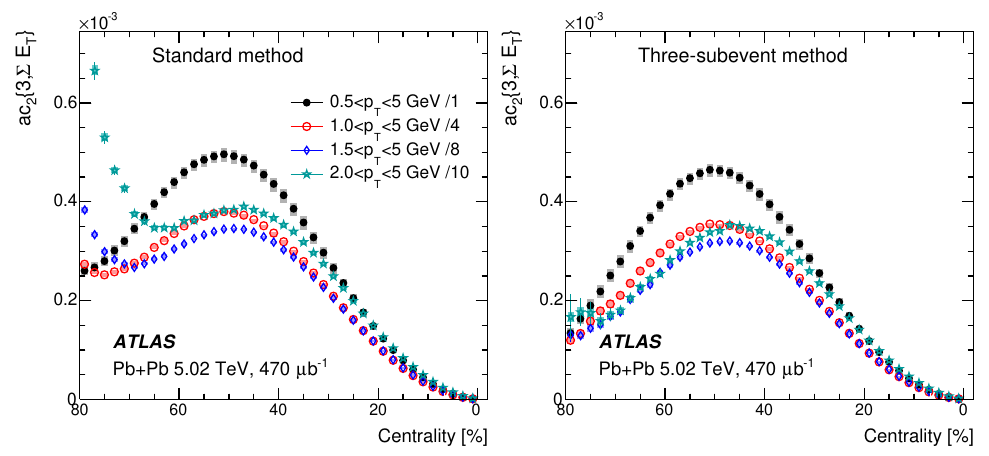
Figure 31 . The ac 2 f 3 g values calculated for charged particles in four p T ranges as a function of centrality for the standard method (left panel) and three-subevent method (right panel). The error bars and shaded boxes represent the statistical and systematic uncertainties,